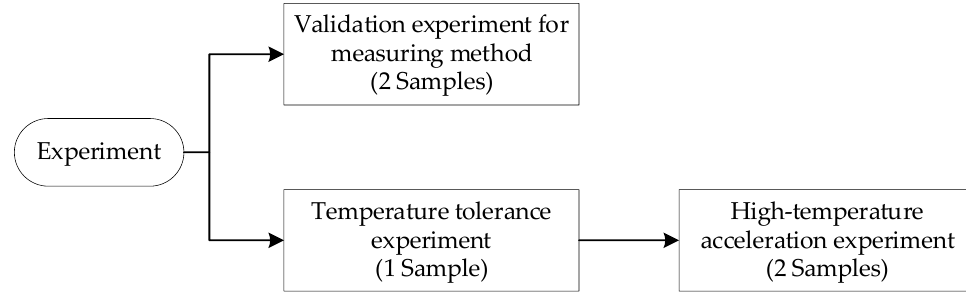
Figure 4. Experimental process.